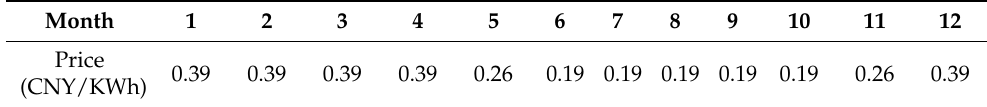
Table 2. Monthly electricity prices.